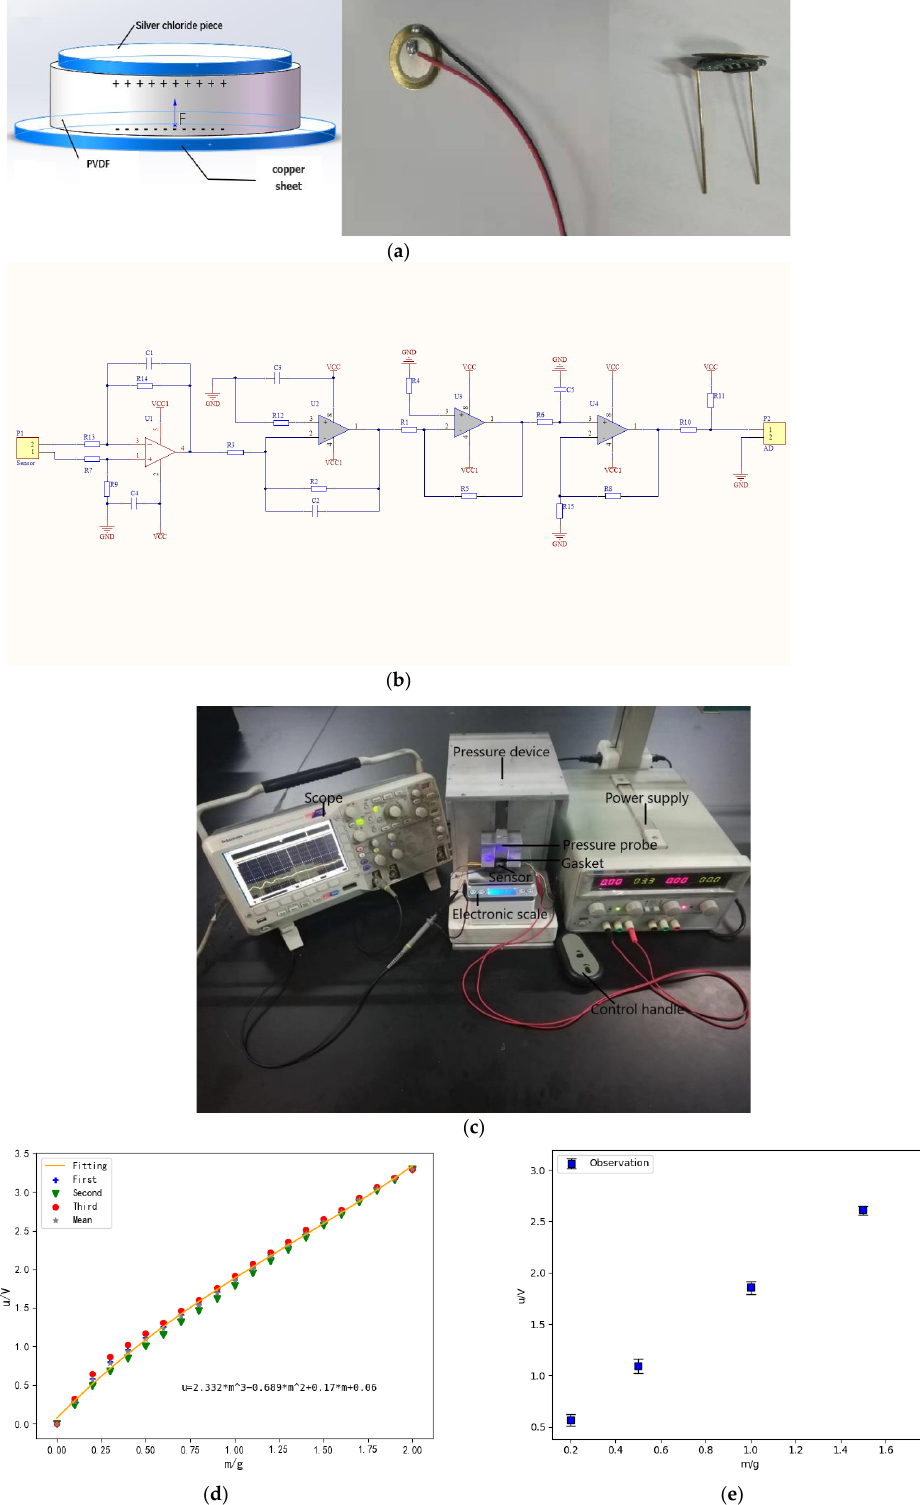
Figure 2. The working principle of the new piezoelectric sensor: ( a ) composite material; ( b ) sensor internal circuits; ( c ) experiment device; ( d ) piezoelectric effect; and ( e ) error analysis.